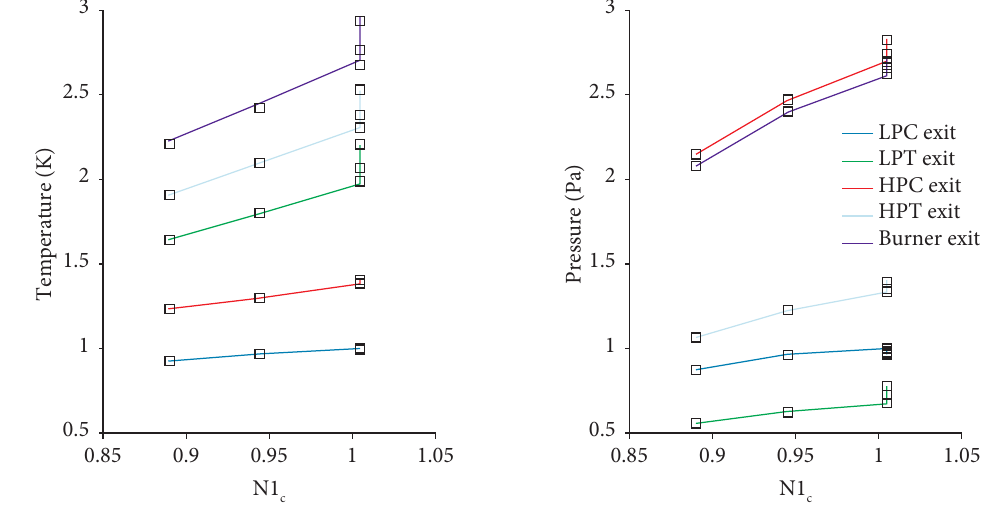
Figure 15. Major gas path parameters from simulation, validated with test bed